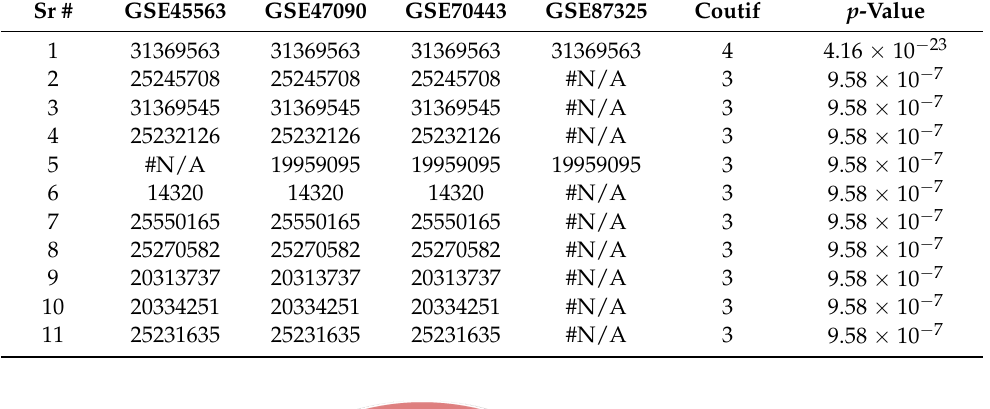
Table 1. The SDGs were screened based on 1-sample proportions test with Bonferroni corrected p < 0.05, discarding other genes that did not become significant with similar criteria. The differential expression data included 4859, 12,723, 172 and 2091 genes from GSE45563, GSE47090, GSE70443 and GSE87325 microarray experiments, respectively.